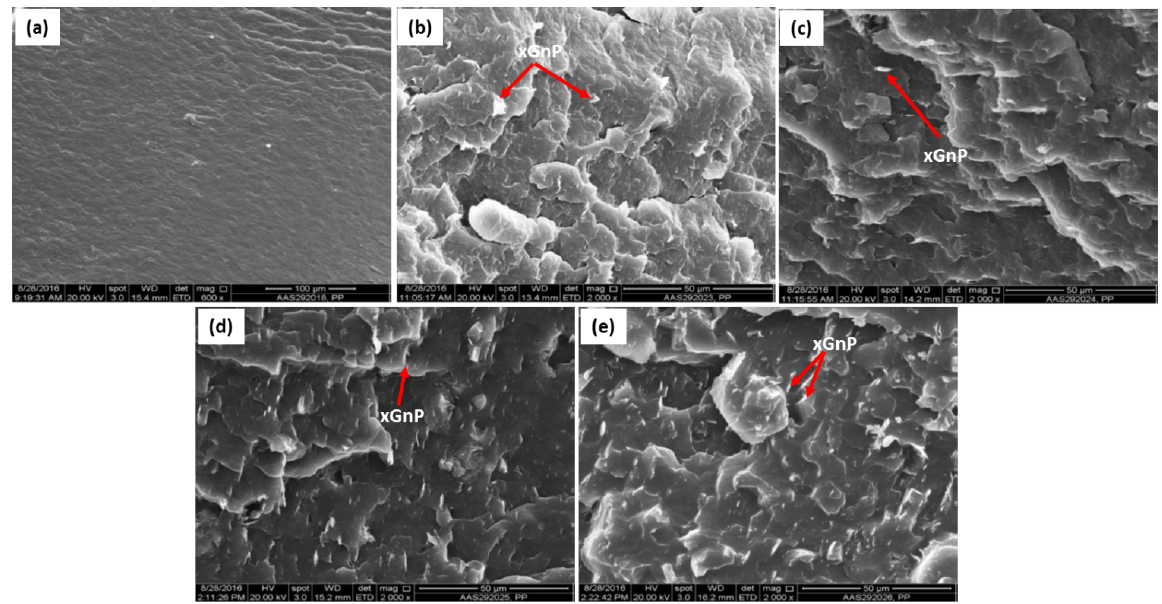
Figure 2: SEM images of PP and its composites: (a) 100 wt.% PP, (b) PP/1xGnP/2n-MgO, (c) PP/2.5xGnP/2n-MgO, (d) PP/5xGnP/2n-MgO and (e)